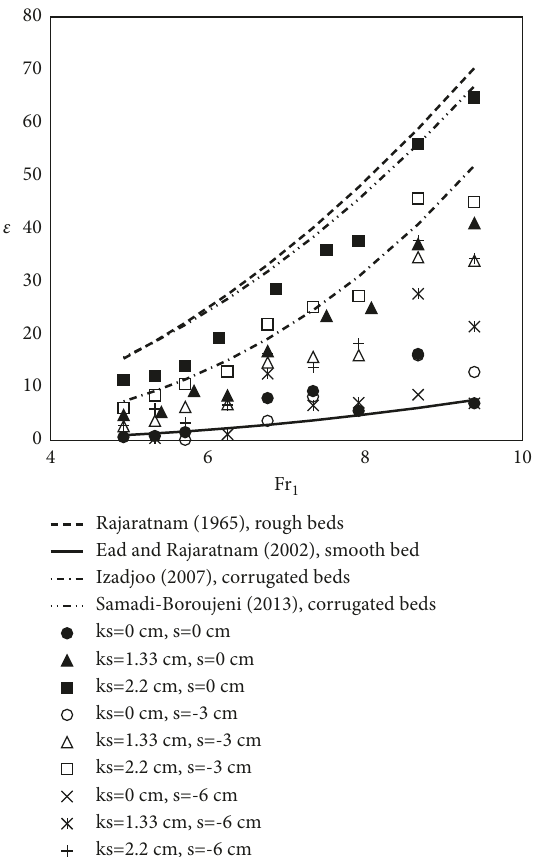
Figure 13: The bed shear stress coefficient as a function of the inflow Froude